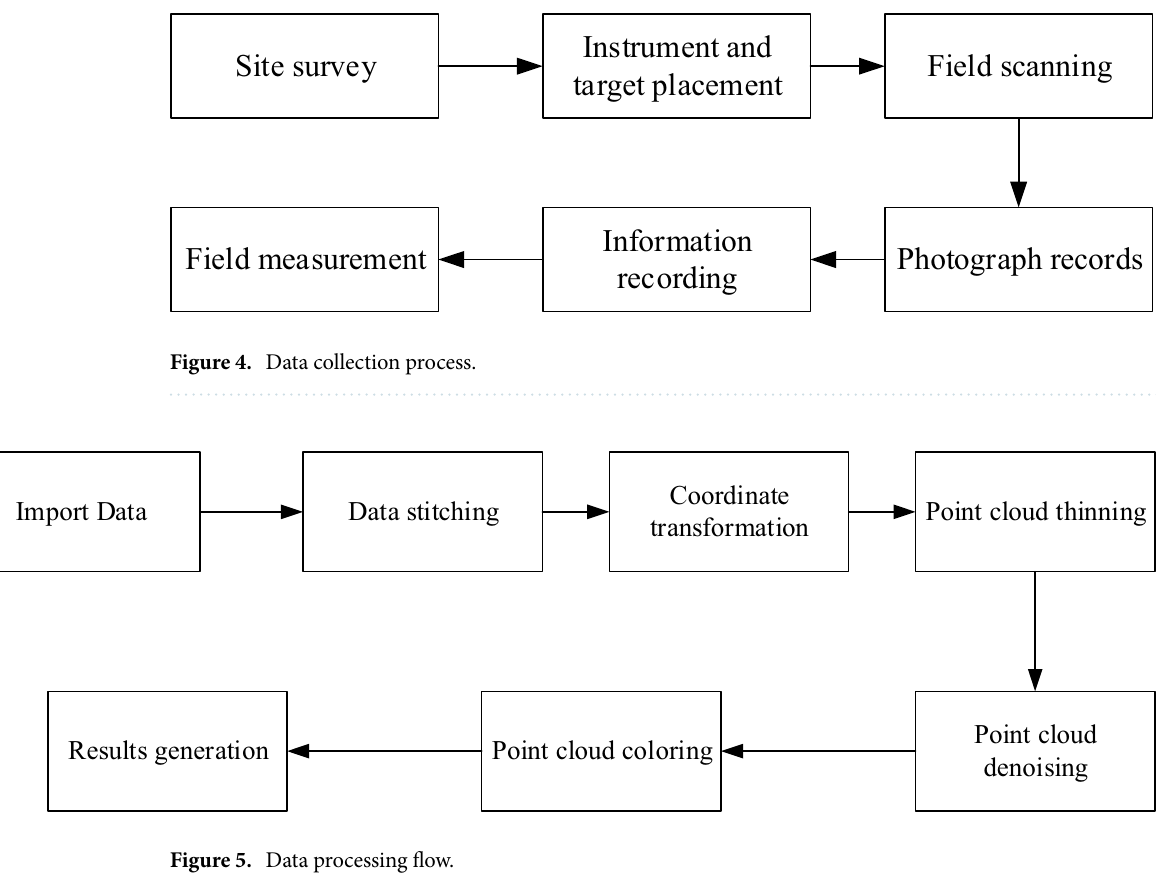
Figure 5. Data processing